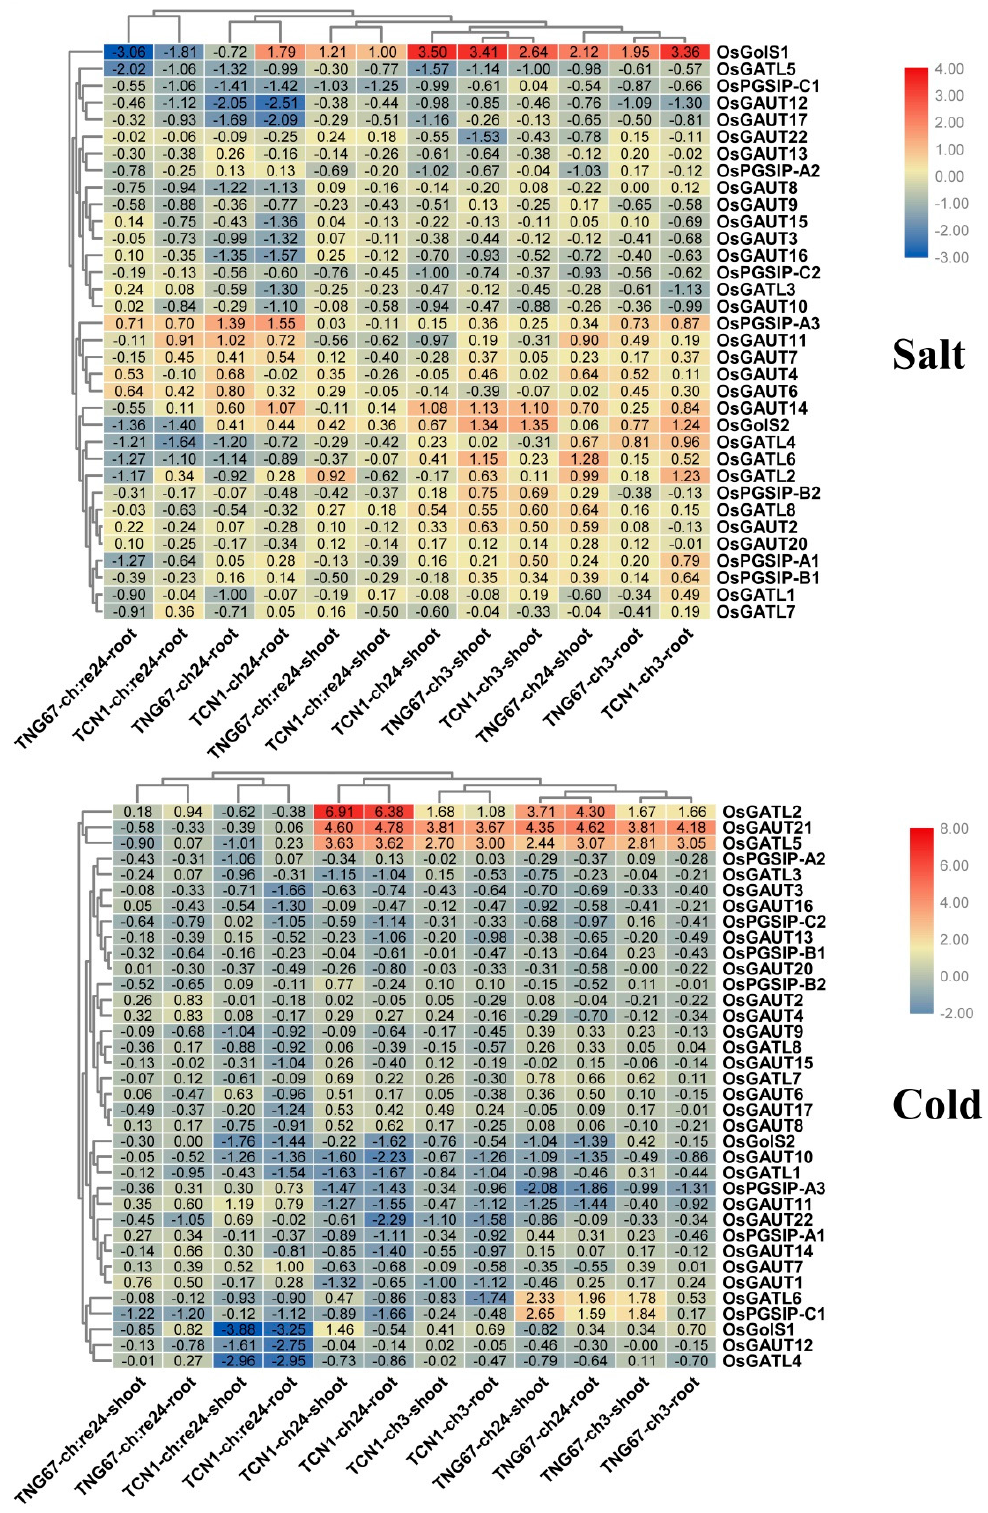
Figure 6. Expression profiles of OsGT8 genes under salt and cold stress. TNG67, TCN1 indicate two rice cultivars. ch3, ch24, ch:re24 represent 3 h after treatment, 24 h after treatment, and subsequent 24 h recovery, respectively. The values in the color scale represent log 2 foldchange : normalization to the control and with significant results for the t -test ( p -value < 0.05) based on six replicates (3 biological repeats × 2 technical repeats) for each treatment compared with the control [36].